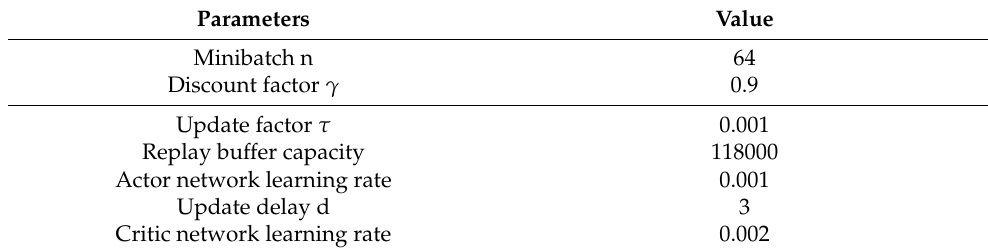
Figure 9 . Hardware ‐ in ‐ loop test platform. Table 2. Parameters of the PER-TD3-based